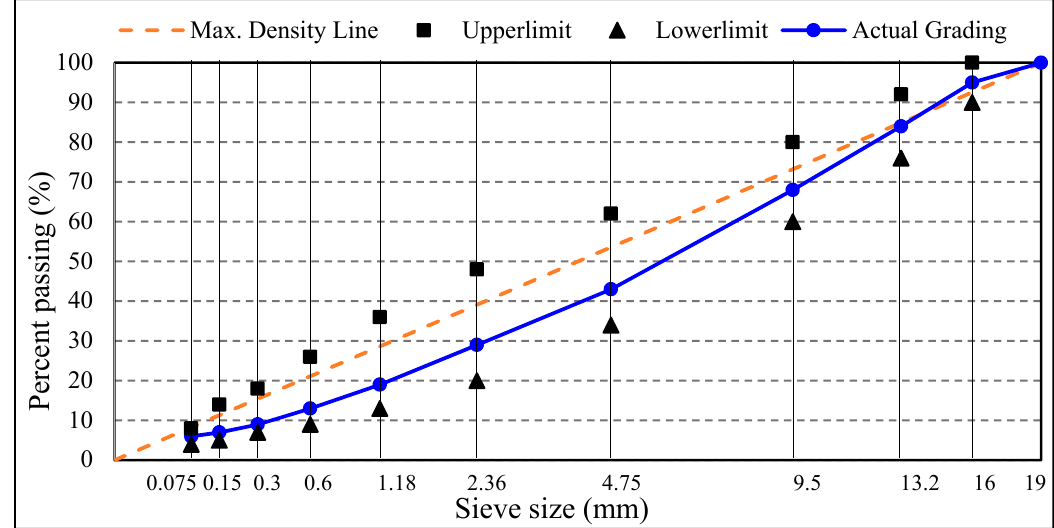
Figure 1. The gradation of dense-graded AC-16C asphalt mixtures.